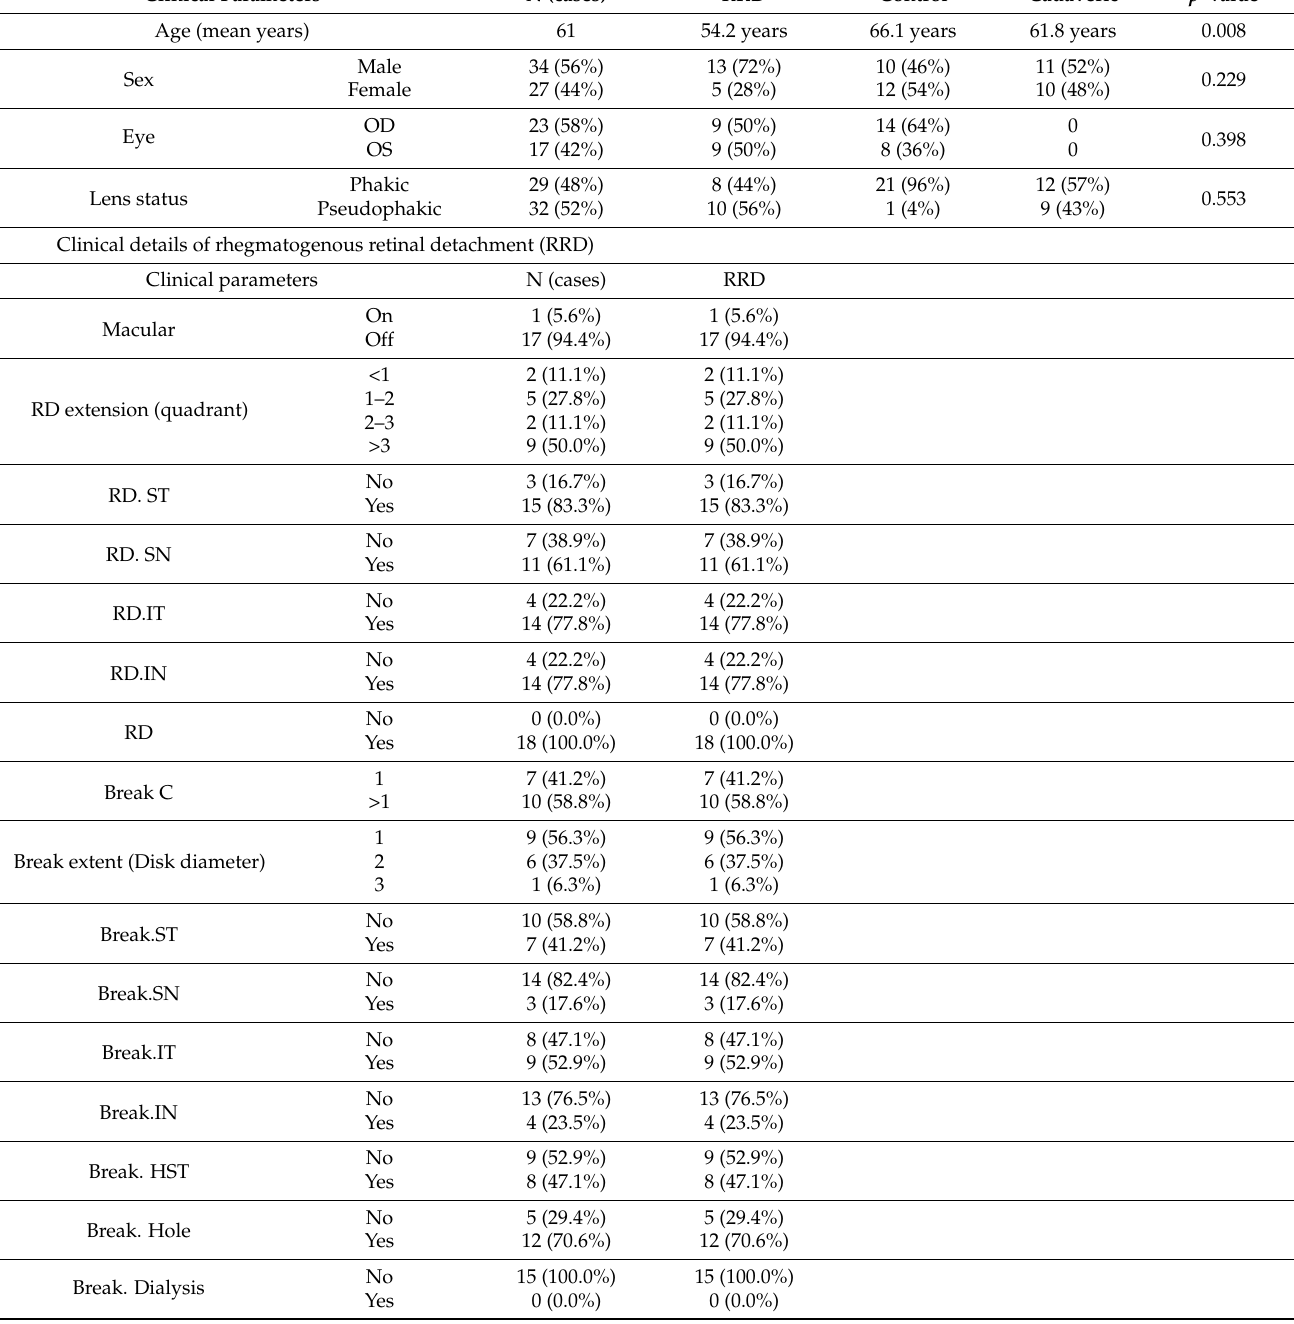
Table 1. Demographic features including sex, laterality, underlying disease, and retinal detachment characteristics found in the case, control, and cadaveric groups. Rhegmatogenous retinal detachment group including extension, location, break number, and macula status is shown. Number indicates number of cases in each group. Rhegmatogenous retinal detachment (RRD); Inferotemporal (IT); Inferonasal (IN); Supratemporal (ST); Supranasal (SN); Horseshoe tear (HST). Bold letter signifies statistically significant